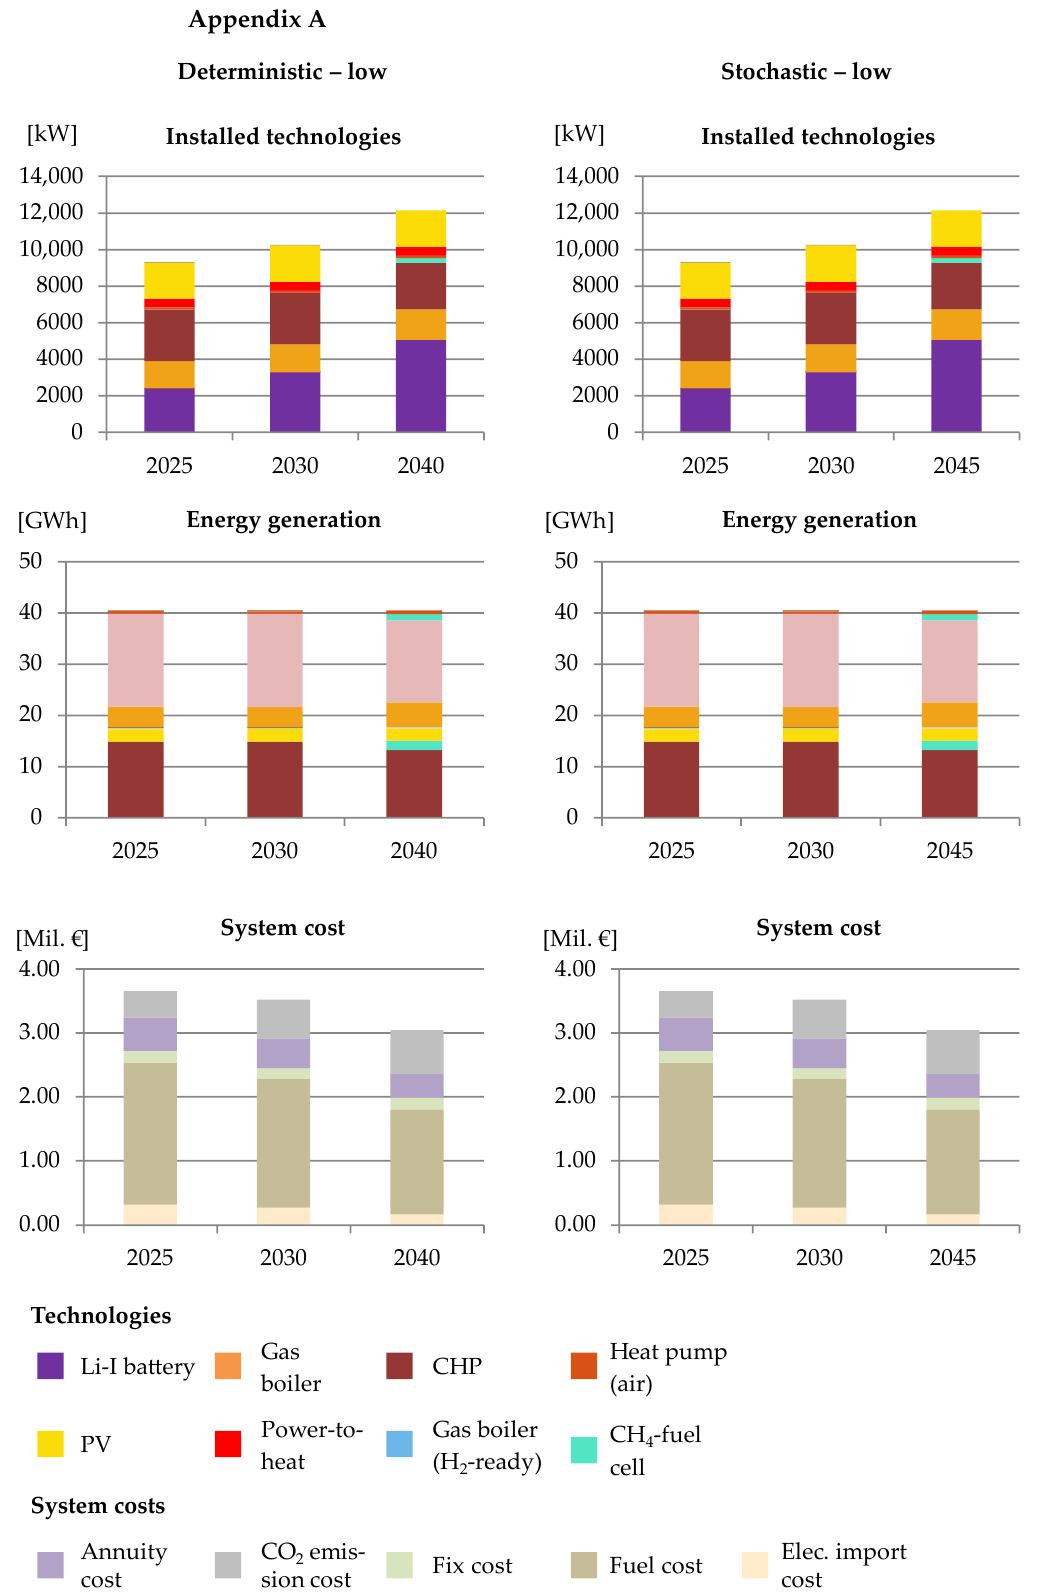
Figure A1. Scenario results for the deterministic–low and stochastic–low setting. Proves the correct implementation of stochastic programming into DISTRICT.